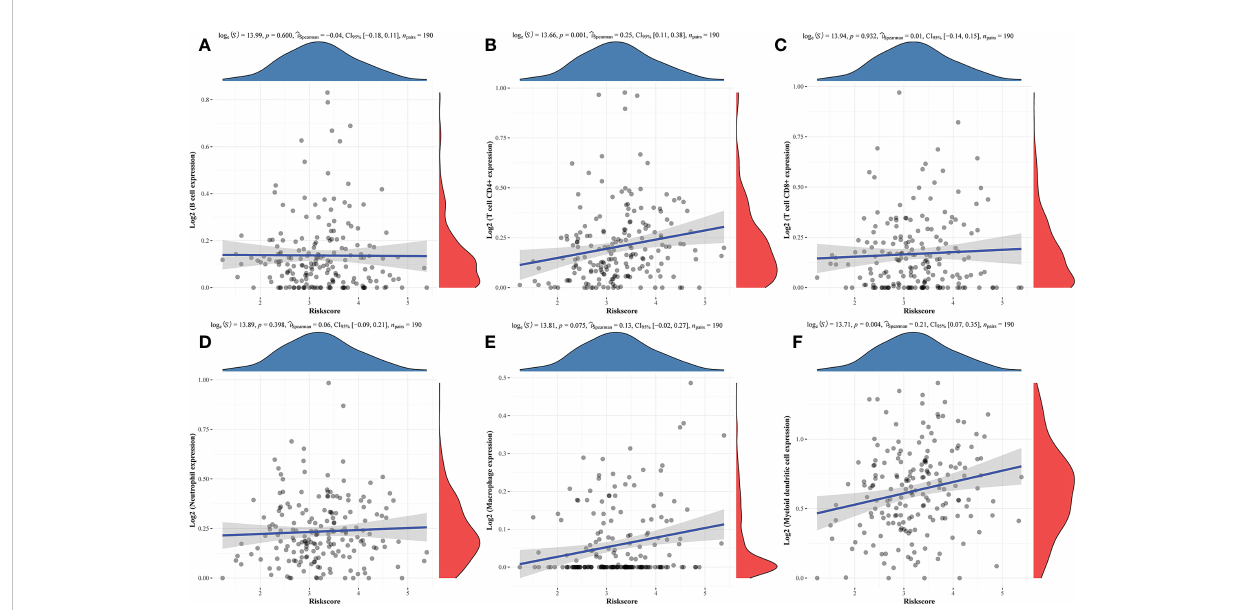
FIGURE 5 Correlations between prognostic risk score values and immune cell in fi ltration. (A-F) Correlations between predictive risk scores and the six indicated immune cell